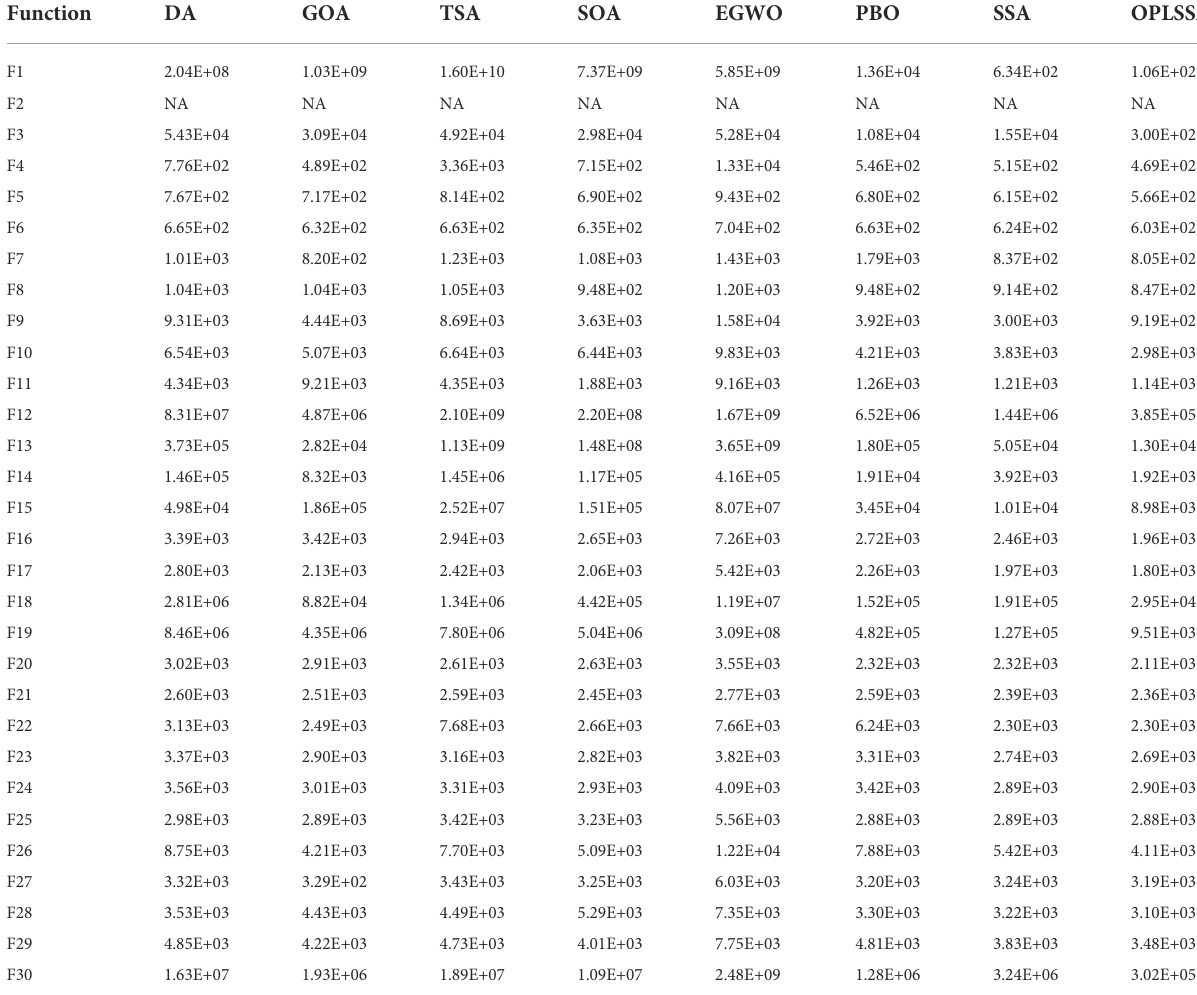
TABLE 9 Results of CEC 2017 at 30-dimensional achieved by the developed algorithm and its competitors.